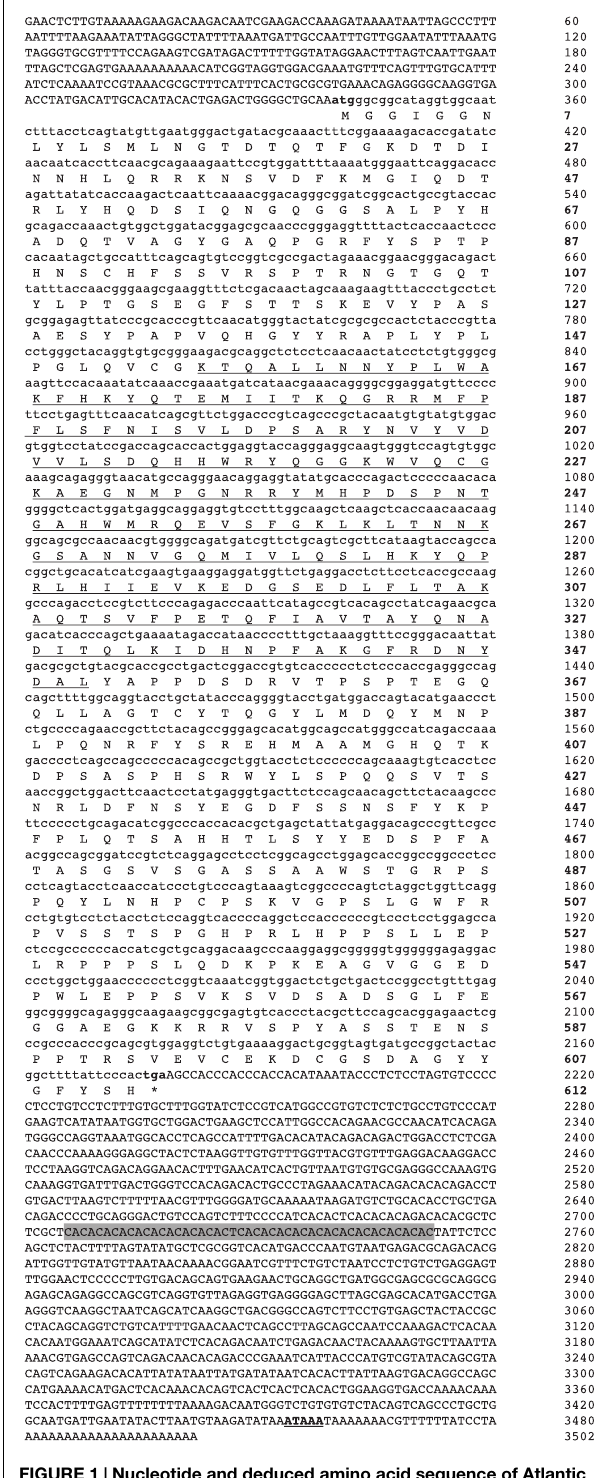
FIGURE 1 | Nucleotide and deduced amino acid sequence of Atlantic salmon T-bet cDNA . Uppercase denotes the UTR’s and lowercase denotes the coding regions. The T-box DNA binding domain is underlined. Start and stop codons are marked with bold letters. The asterisk indicates the stop codon. The putative polyadenylation signal is bold and underlined. A region of repeat with 23 copies of the consensus sequences CA (2bp) is shaded.